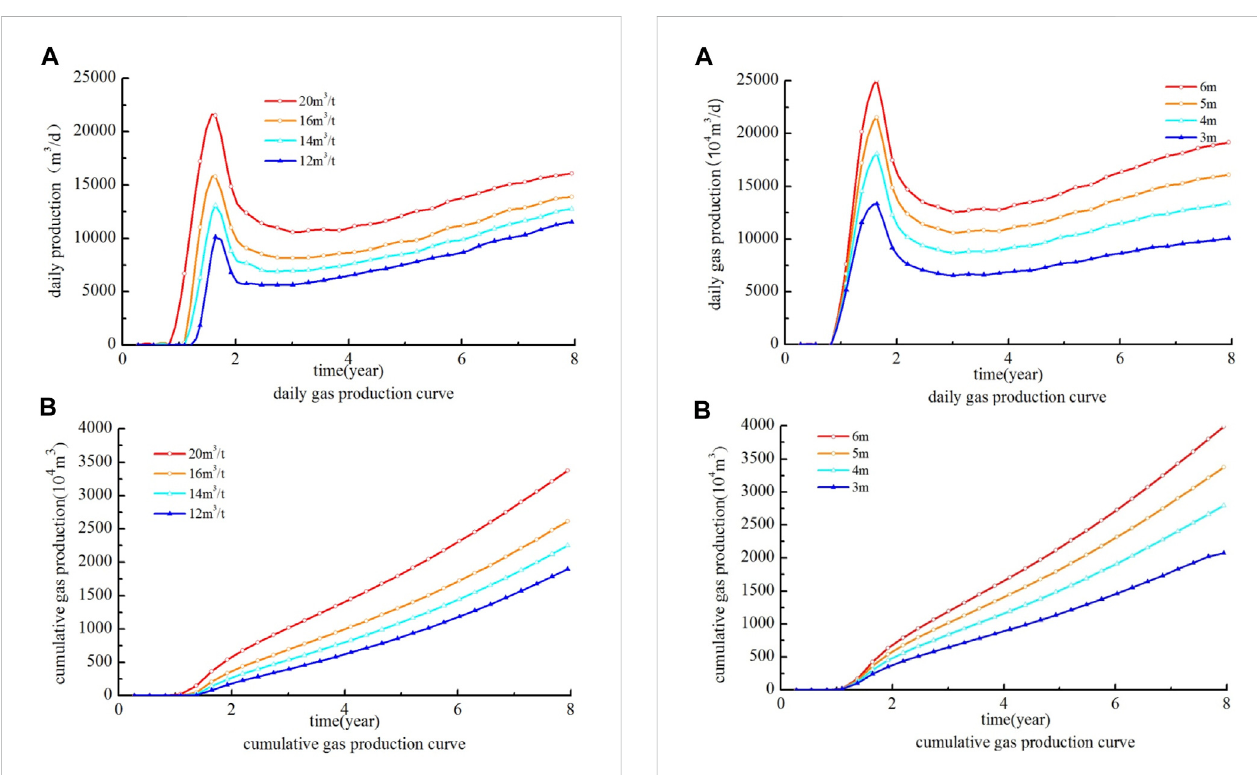
FIGURE 6 Variation curve of gas production with coal thickness. (A) daily gas production curve, (B) cumulative gas